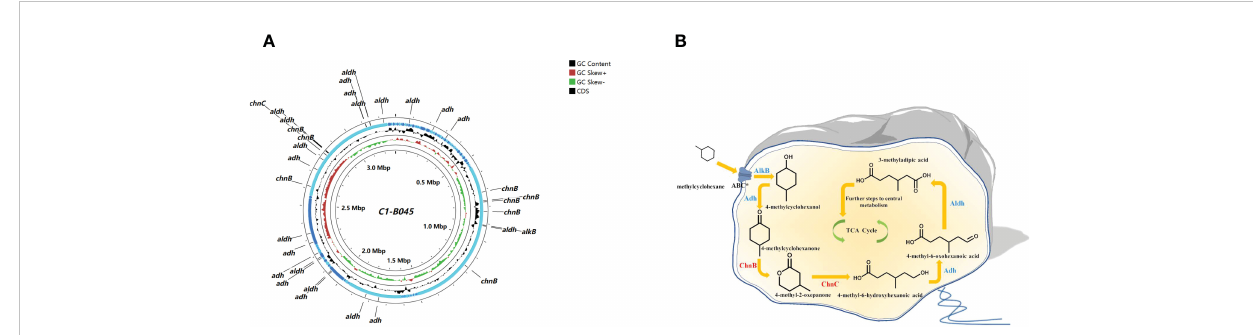
FIGURE 4 Key genes encoding degradation pathway for MCH in the MAG of C1-B045 derived from the CIR core sediment. (A) circular representation of the MAG of C1-B045 . CGView map represents the coding sequence (annotated by RAST), contigs, GC skew, GC content, and genome backbone from outside to inside, respectively. alkB , alkane 1-monooxygenase; chnB , cyclohexanone monooxygenase; chnC , 6-hexanolactone hydrolase; adh , alcohol dehydrogenase; aldh , aldehyde dehydrogenase. (B) putative MCH degradation pathway with key enzymes predicted in the MAG of C1-B045 . * indicates the transporter ABC is not annotated in this